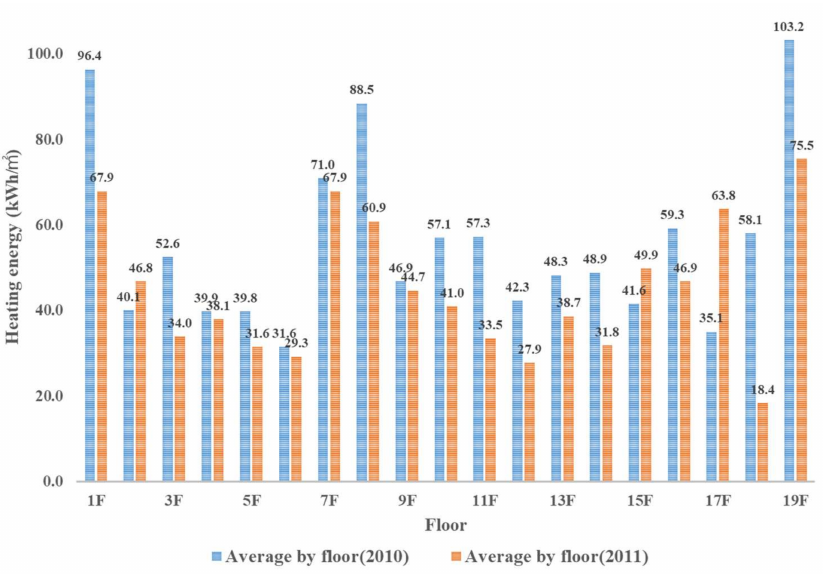
Figure 9. Distribution of measured heating energy consumption by the height of households.